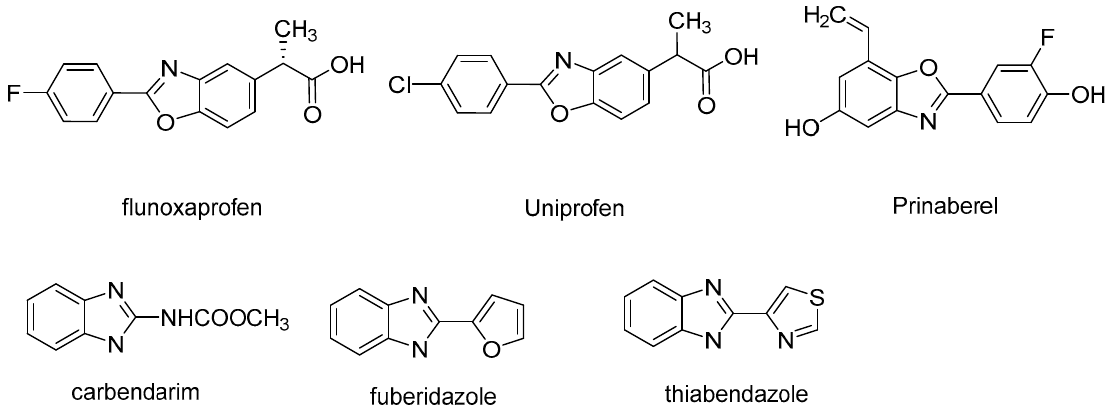
Figure 1. Typical compounds of benzoxazoles.